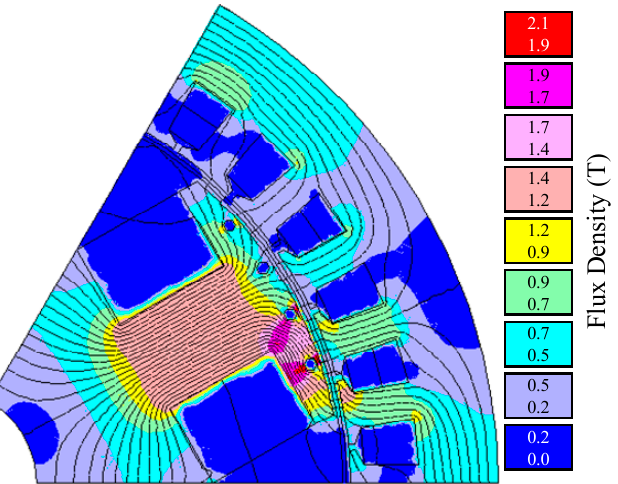
Figure 11. Finite-element solution of the magnetic field distribution and magnetic flux density under full-load operation. Table 6. Main electromagnetic results.